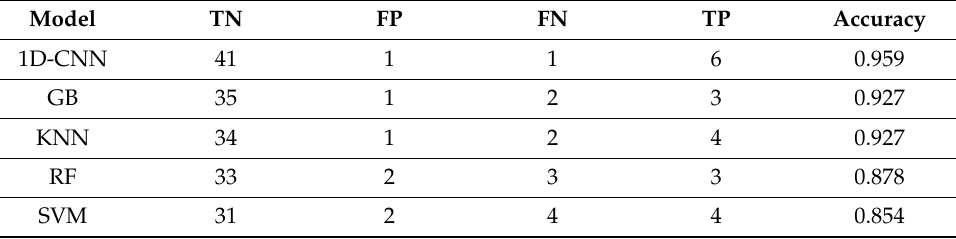
Table 12. Comparative model validation result of the slurry test with PLUG_SIGN as the